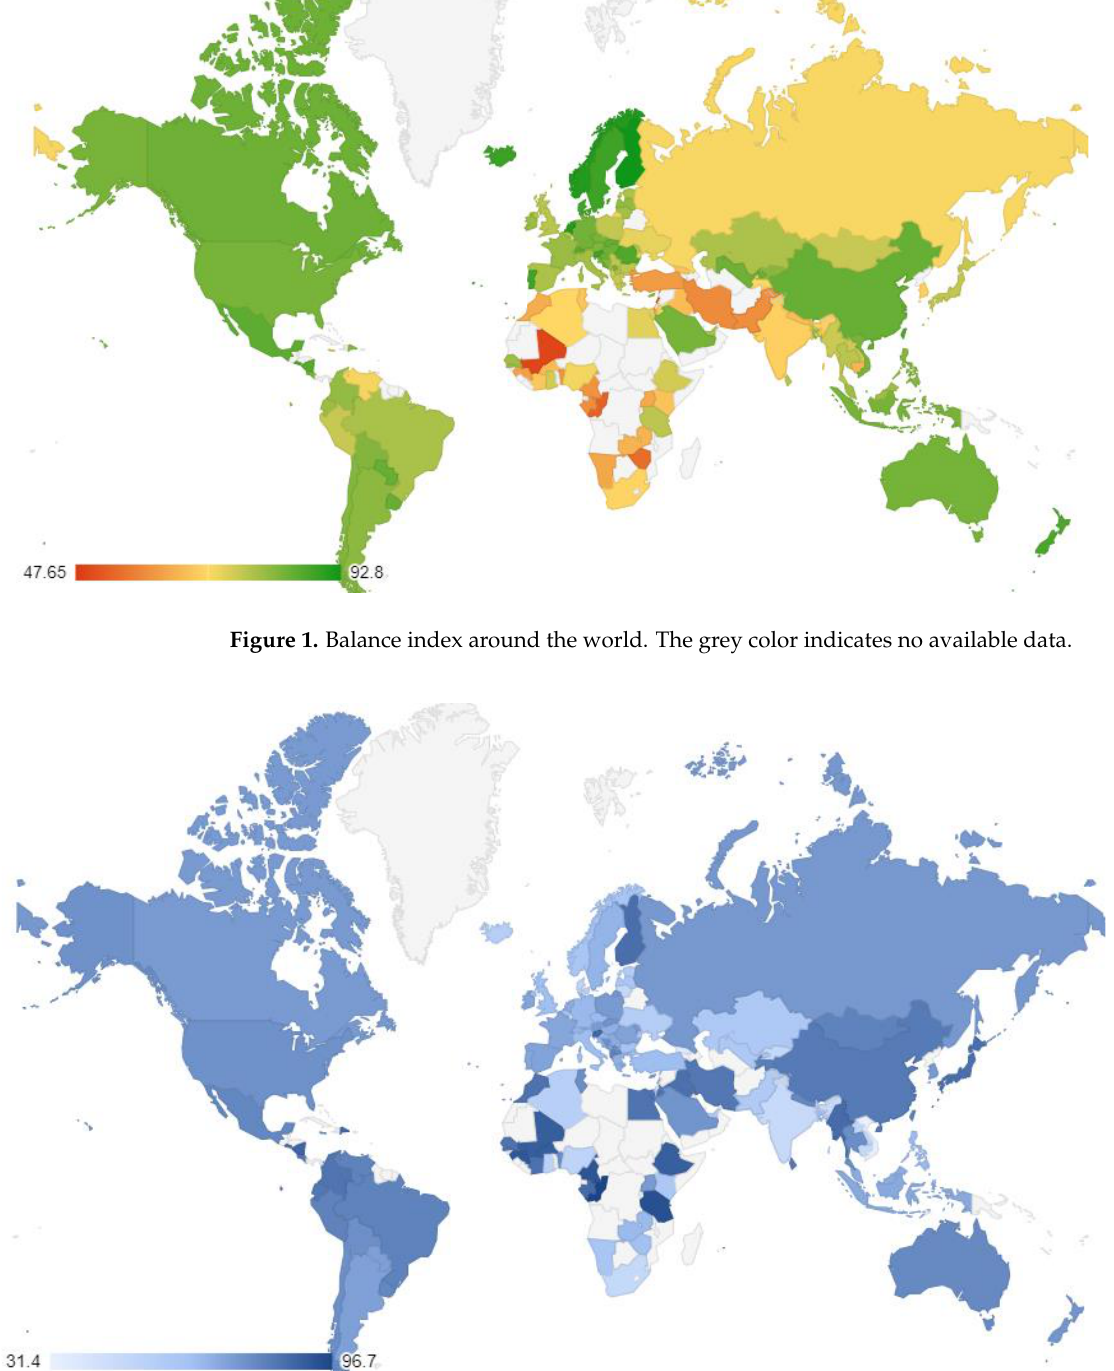
Figure 2. Preference for a calm life around the world. The grey color indicates no available data.